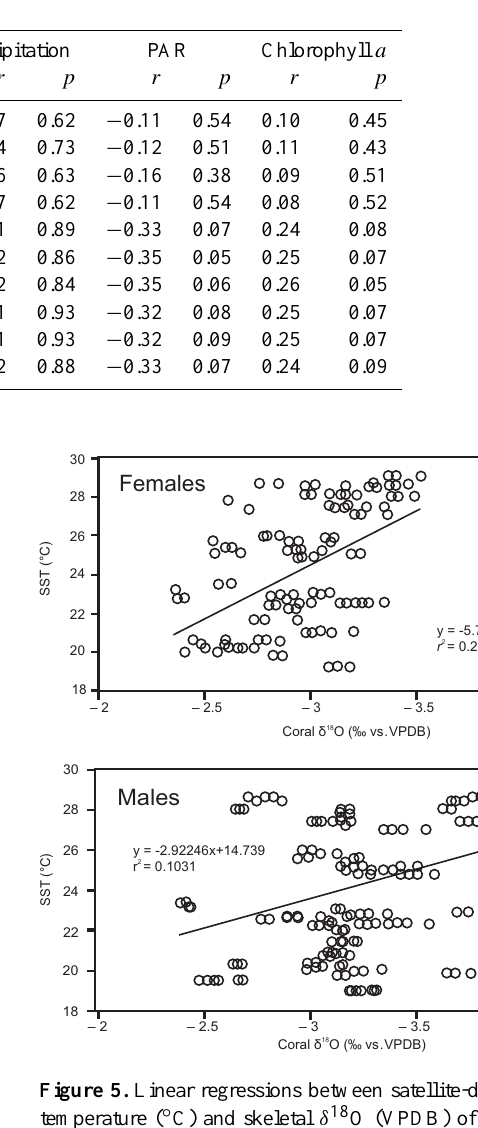
Table 3. Correlation coefficients between skeletal δ 13 C of Porites panamensis colonies and: sea surface temperature, precipitation, photo- synthetically active radiation and chlorophyll a from Bahía de La Paz. Time period covered by correlations is from 1997 to 2009. Temporal resolution of data is quarterly. Bold numbers indicate significant ( p< 0 . 05) correlations.